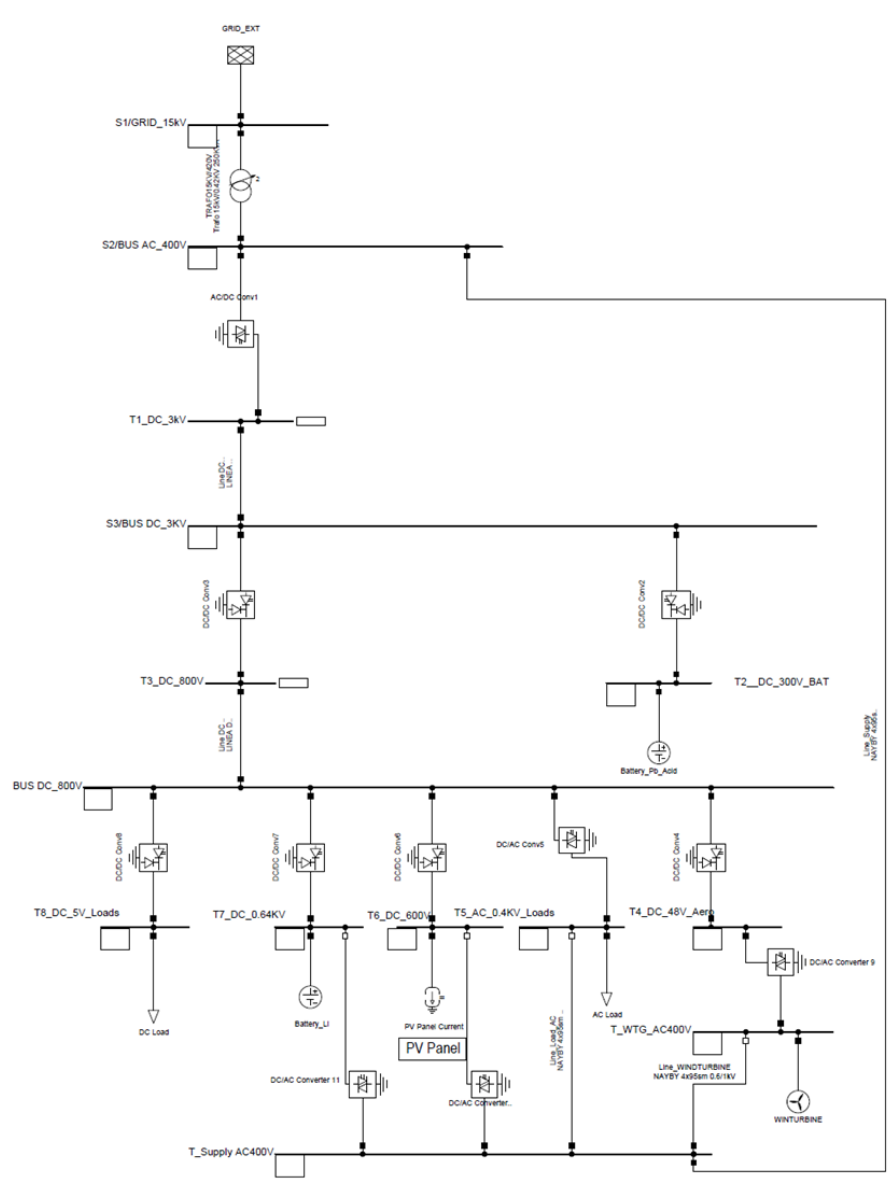
Figure A1. Set-up of the MG in PowerFactory, DIgSILENT.